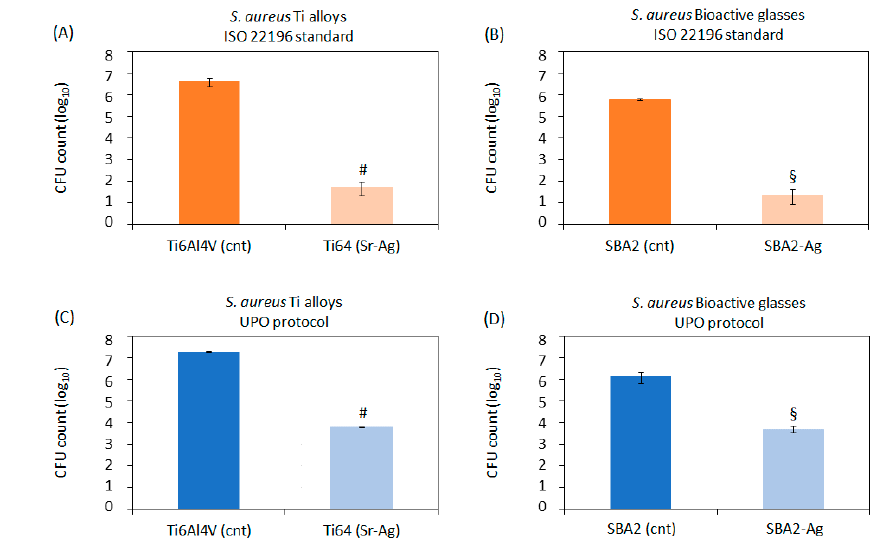
Figure 6. Antibacterial evaluation according to ISO standard (upper panel—( A , B )) and UPO protocol (lower panel—( C , D )). Both the assays demonstrated that the Ag-doped specimens were able to significantly reduce the bacteria number in comparison with the untreated controls ( p < 0.05, indicated by # and §, respectively). The bars represent means ± standard deviations.